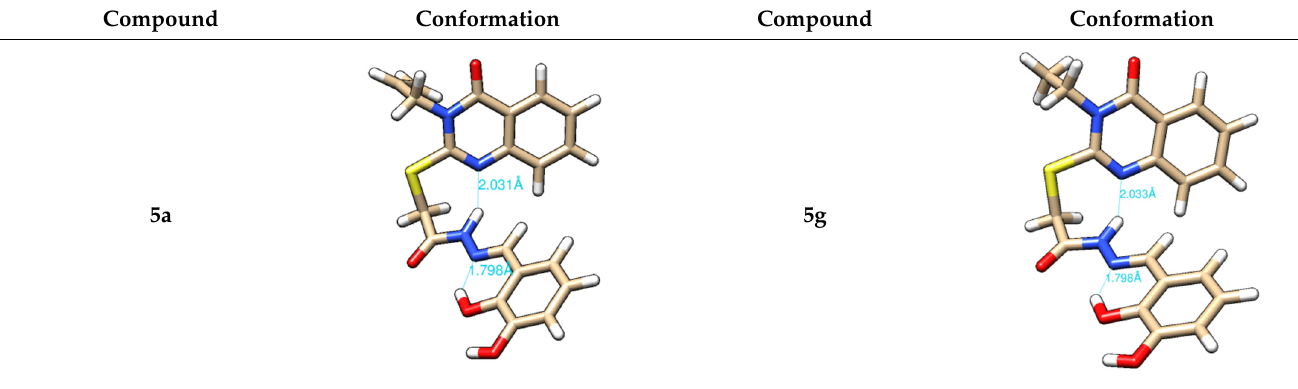
Table 7. The energy of the frontier orbitals and the BDE for the H 1 –H 5 sites in the studied com- pounds, according to the numeration presented in Figure 3.